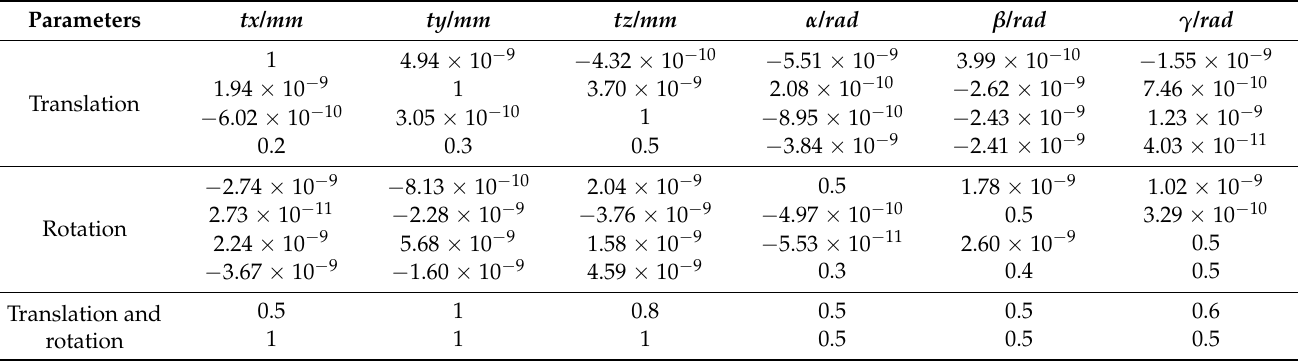
Table 3. Coordinate transfer matrix T 2 calculated through surface matching.